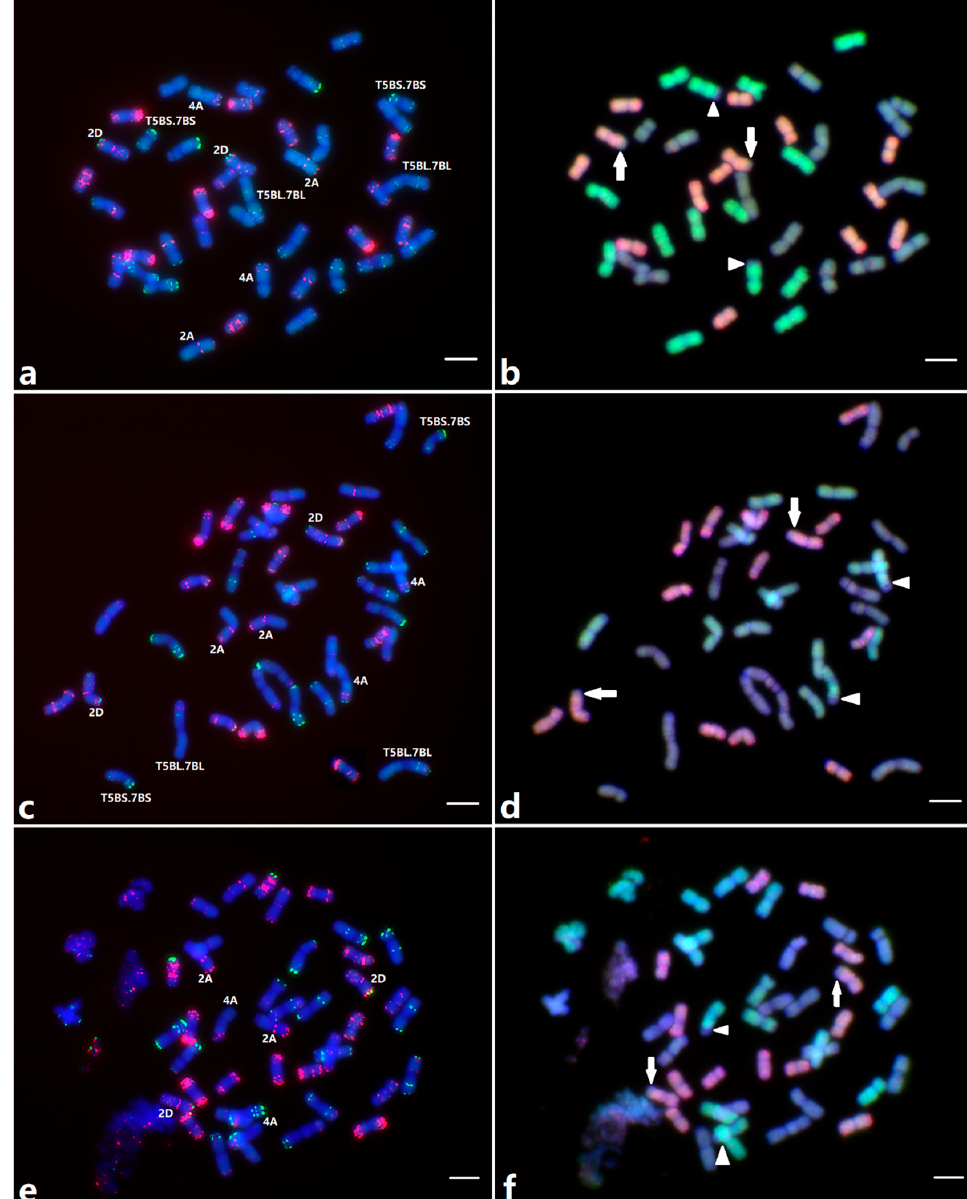
Figure 4. Sequential FISH ( a , c , e ) and GISH ( b , d , f ) analyses of cultivars Arina ( a , b ), Cezanne ( c , d ) and Forno ( e , f ). These experiments were performed on the same metaphase cell for each cultivar. For FISH, chromosomes were hybridized with Oligo-pSc119.2-1 probes labeled with 6-FAM and Oligo-pTa535-1 labeled with Tamra, generating green and red signals, respectively. Chromosomes were counterstained with DAPI and fluoresced blue dye. For GISH, DNA from Tritcum urartu and Aegilops tauschii were labeled with fluorescein-12-dUTP and rhodamine-5-dUTP to differentially fluoresced A and D chromosomes, respectively. Chromosomes were again counterstained with DAPI and fluoresced blue. Arrowheads point to the translocation breakpoints on the 4AL-5AL-7BS translocation chromosomes in all three cultivars. The reciprocal translocation chromosomes T5BS.7BS and T5BL.7BL in Arina ( b ) and Cezanne ( d ) are labeled. Arrows point to the breakpoints on 2DL (interstitial translocations in Arina ( b ) and Cezanne ( d ); distal translocation in Forno ( f )). Scale bars represent 10 µm.